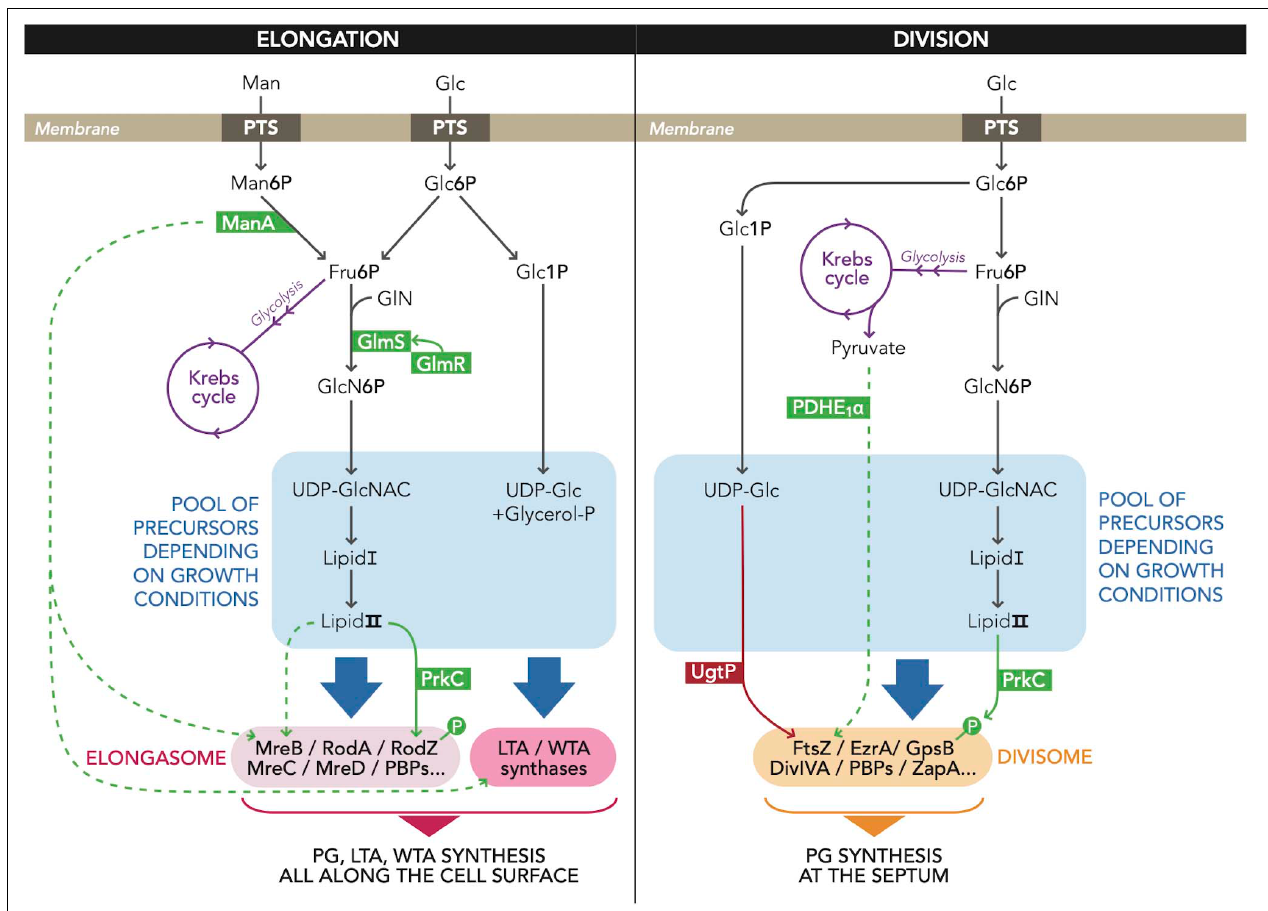
FIGURE 1 | Schematic summary of metabolic regulations of CW elongation and cell division in B. subtilis described in the review. The two panels represent regulations of bacterial CW elongation (left) and cell division (right) by proteins whose activity or function is modulated by metabolic intermediates. Metabolic changes adjust the pool of precursors, visualized in blue boxes, in order to regulate LTA, WTA, or PG synthesis. Metabolic reactions are drawn with black arrows and the enzymes involved in the regulations are represented in green or red boxes. The several levels of regulation are mapped by dotted arrows, green for activations and red for inhibitions. When direct interaction exists between proteins and metabolites, dashed arrows are converted to solid lines. The available precursors are then used by LTA synthases and proteins from the elongasome or the divisome for CW synthesis all along the cell surface or at the septum, respectively. Abbreviations: Man, mannose; Man6P, D -mannose 6-phosphate; Glc, glucose; Glc6P, D -glucose 6-phosphate; Glc1P, D -glucose 1-phosphate; Fru6P, fructose 6-phosphate; GlN, glutamine; GlcN6P; glucosamine-6-phosphate; UDP-GlcNAc, uridine diphosphate N-acetylglucosamine; UDP-Glc, uridine diphosphate glucose; AcylACP,